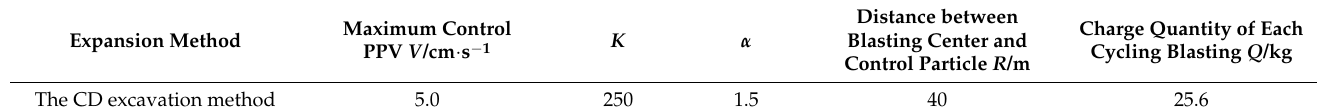
Table 1. The permitted maximum explosive charge per detonating period.